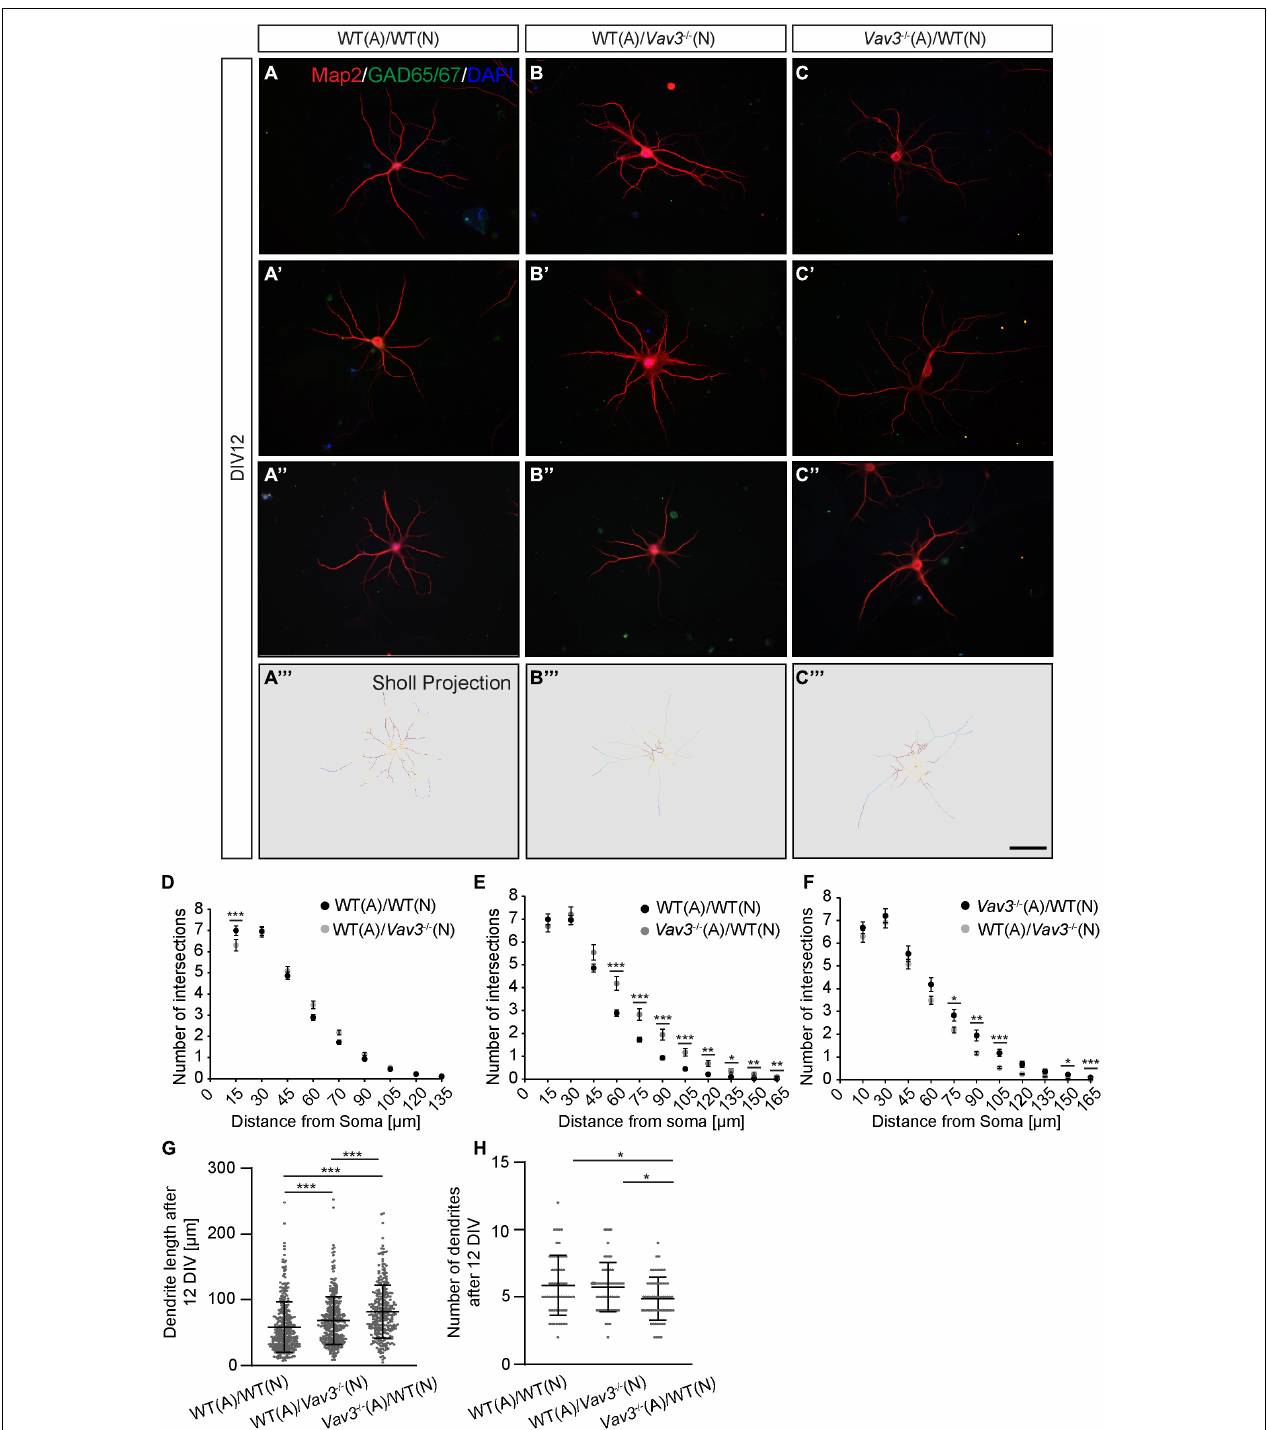
FIGURE 2 | (A–A”, B–B”, C–C”) After a culturing time of 12 days neurons were immunocytochemically stained with specific antibodies against the dendritic marker Map2 and the interneuron marker GAD65/67. Furthermore DAPI was used for the visualization of nuclei. The GAD65/67 positive neurons were excluded from the analysis since interneurons have a highly differing morphology in comparison to pyramidal neurons and might falsify the experimental outcome. Three exemplary neurons are depicted per condition. (A”’–C”’) A Sholl analysis was performed for determining the dendritic complexity. The projections depict the skeletonized dendrites and red areas represent a high number of intersections while blue regions represent a low number of intersections, (D–F) The quantification of the Sholl analysis could show that especially wildtype neurons cultured with Vav3 − / − astrocytes developed more complex dendrites than neurons of both other